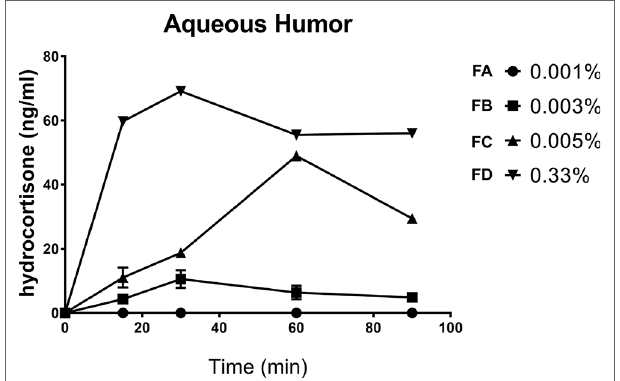
FIGURE 4 | Aqueous distribution of hydrocortisone after instillation of four formulations in the rabbit